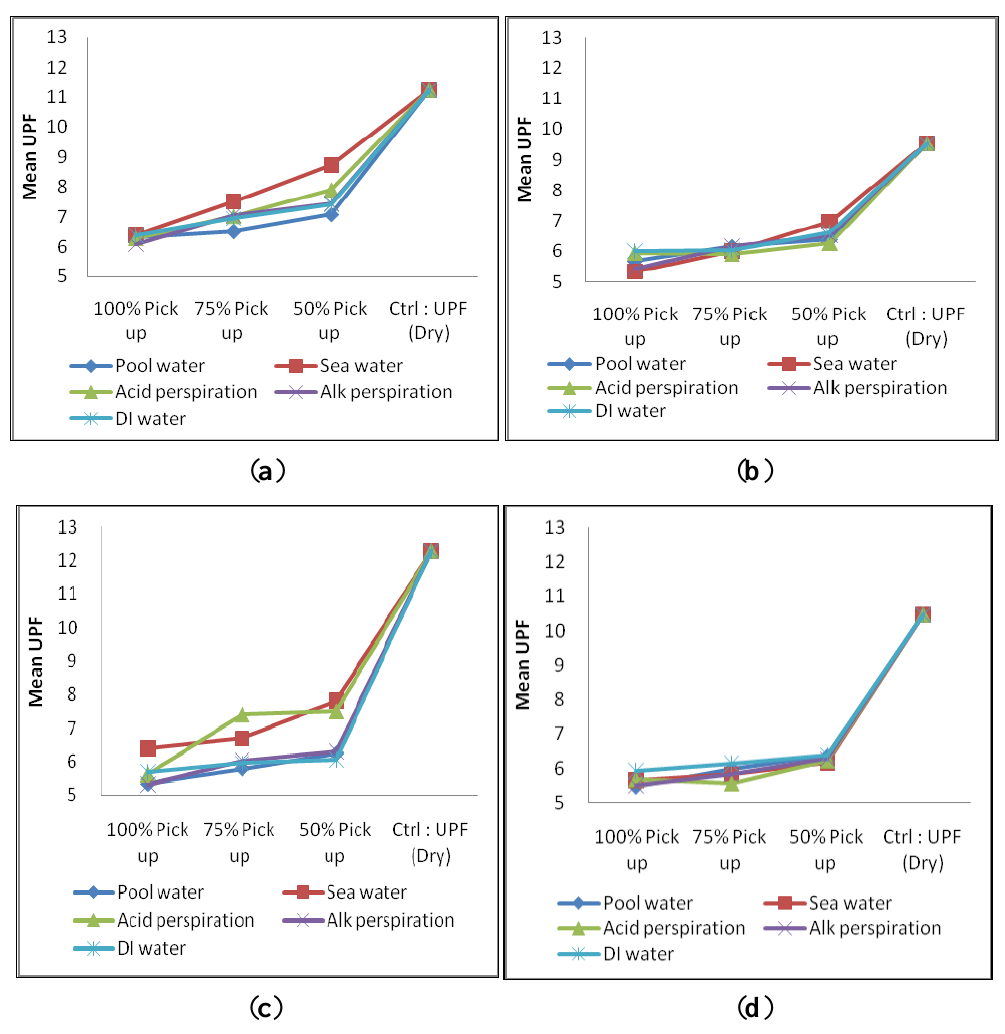
Figure 2. Ultraviolet protection factor (UPF) of samples in Group I: ( a ) CH; ( b ) MCG; ( c ) F and ( d ) MF wetted with five type of solution at three different pick-up percentages.